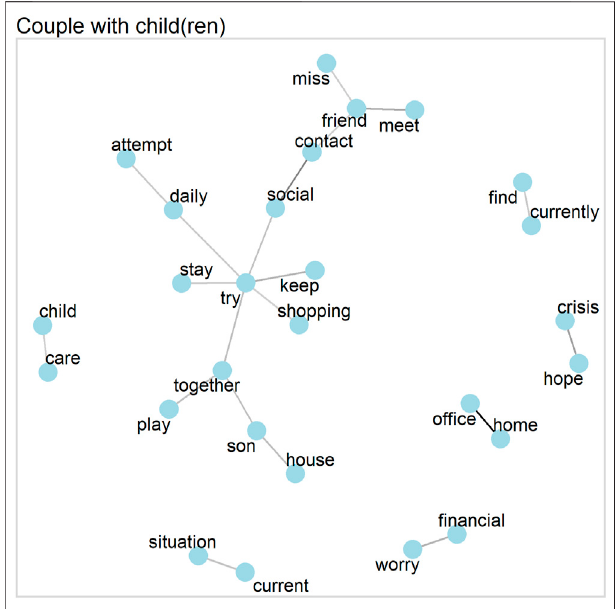
FIGURE 3 | Word network for couples with child(ren) (correlations >